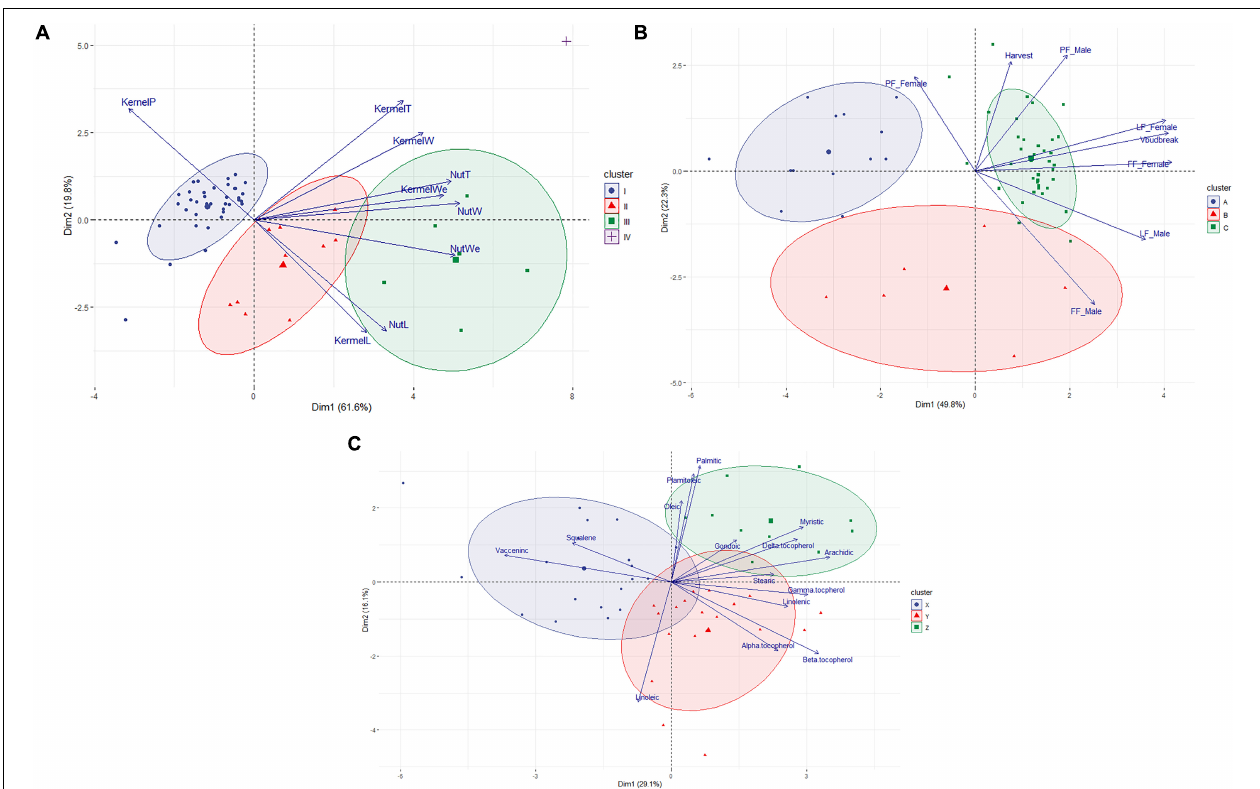
FIGURE 2 | Biplots showing the results of the Hierarchical Clustering on Principal Components analysis for the three sets of evaluated traits. (A) Biplot showing the distribution of the 56 hazelnut accessions considering the eight phenological traits and obtained from two main estimated dimensions. (B) Biplot showing the distribution of the 56 hazelnut accessions considering the nine morphological characters of hazelnut and obtained from two main estimated dimensions. (C) Biplot showing the distribution of the 47 hazelnut accessions considering the chemical composition of their oil and obtained from two main estimated dimensions. Ellipses representing the clusters were drawn considering, p >